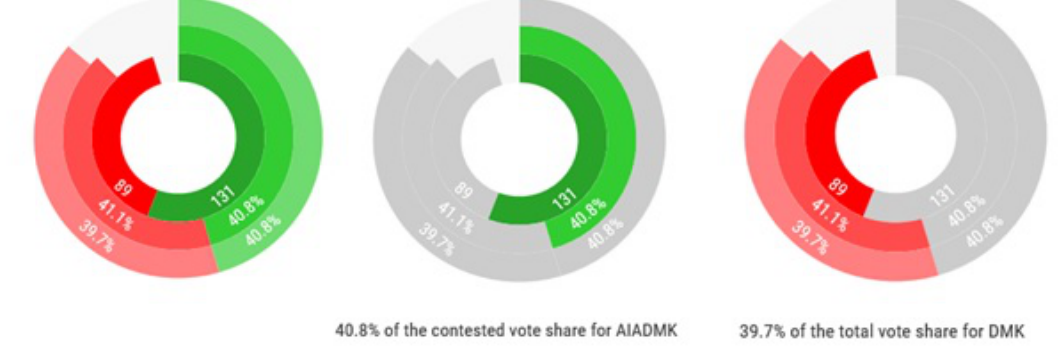
Figure 7: Vote-Shares Using Multi-Level Pie Charts.